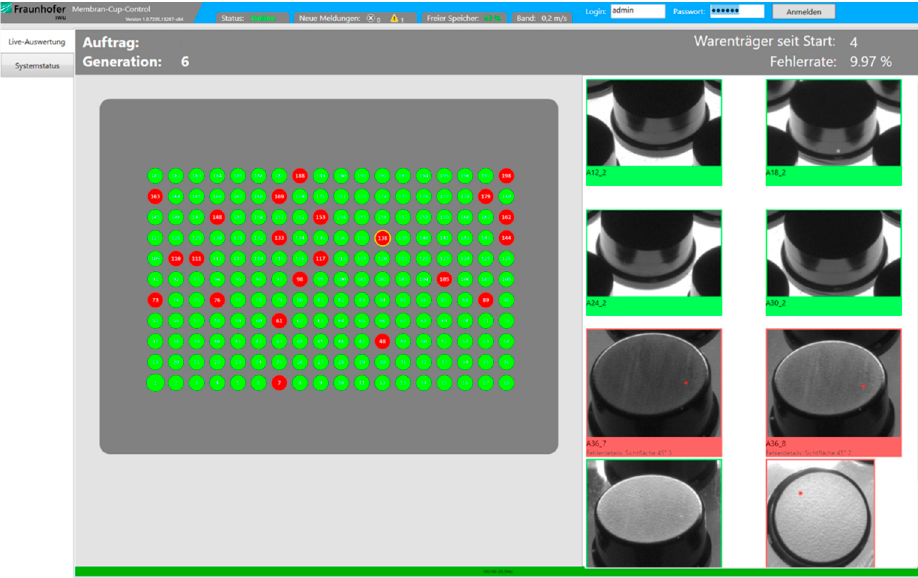
Figure 2. User interface of the inspection system with tray overview on the left and detailed view of a selected part on the tray (green = good status, red = defective) on the right. The results are achieved with the classical filter-based vision methods described in Table 1, Section 4.1.